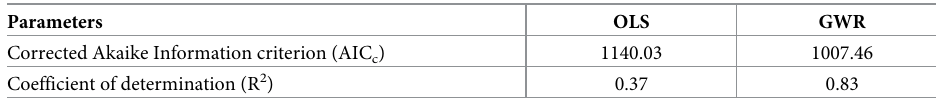
Table 8. Comparison between the model performances of OLS and